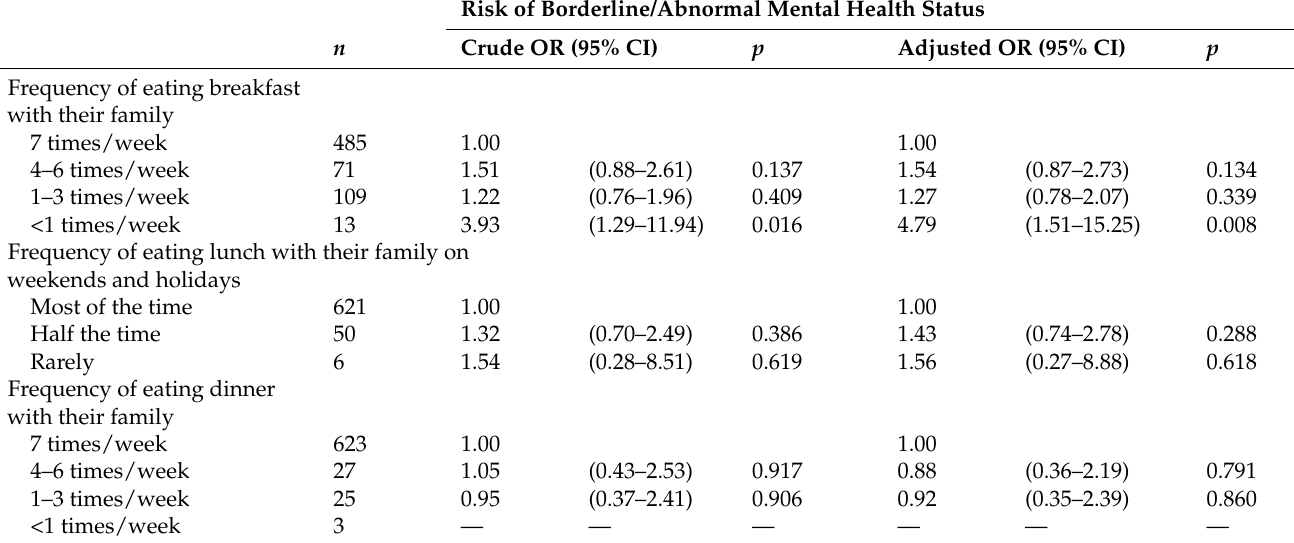
Table 3. Relationship of the frequency of family meals and the prevalence of borderline/abnormal mental health status assessed by the Strengths and Difficulties Questionnaire among Japanese elementary schoolchildren (N = 678). Risk of Borderline/Abnormal Mental Health Status n Crude OR (95% CI) p Adjusted OR (95%